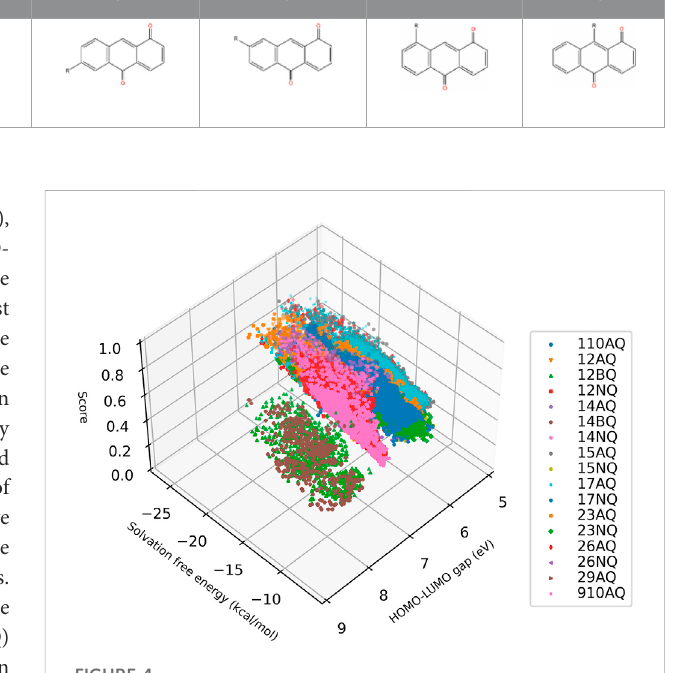
FIGURE 4 A score of over 100,000 virtual quinone molecules. The score